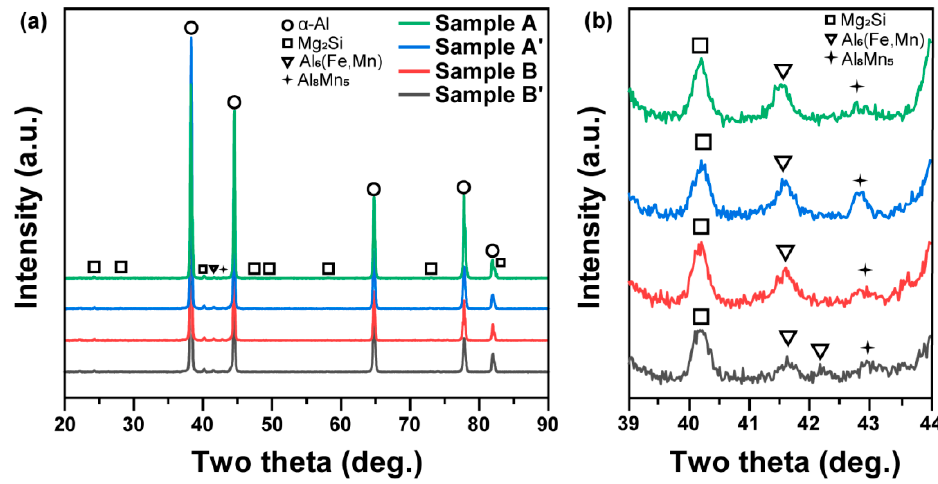
Figure 2. Phase identification of ( a ) the Sc-free/microalloyed Al5083 alloys using 2 θ scans of XRD with ( b ) the magnified XRD profiles from 39°–44° for the phase identification of the precipitates. Table 3. Experimental and calculated 2 θ Angles with the corresponding differences for the Al phase.